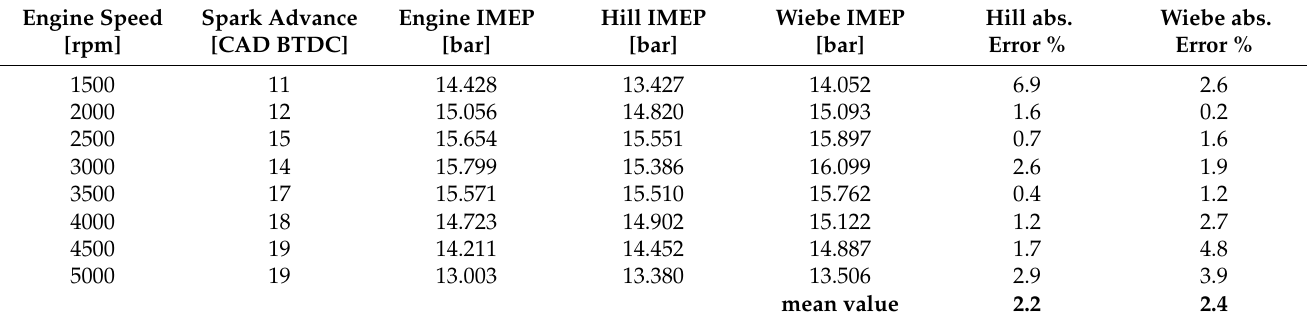
Table 7. Experimental and simulated IMEP with absolute prediction errors (40% NG; MAP = 1.6 bar).